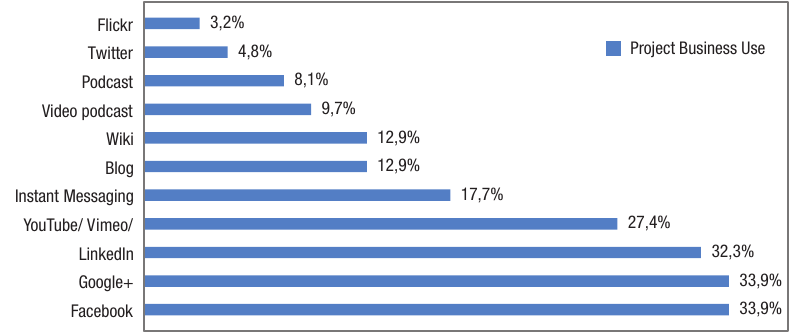
Fig. 7. Usage of social media channels